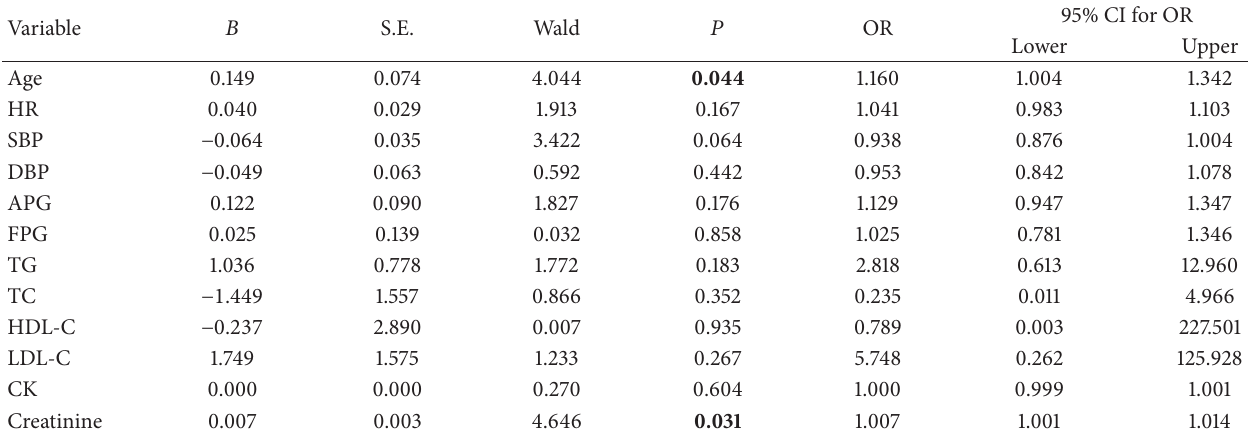
Table 5: Logistic regression analysis for mortality rate in diabetic